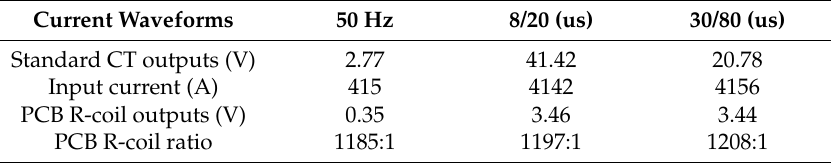
Table 8. Results of the frequency experiments.